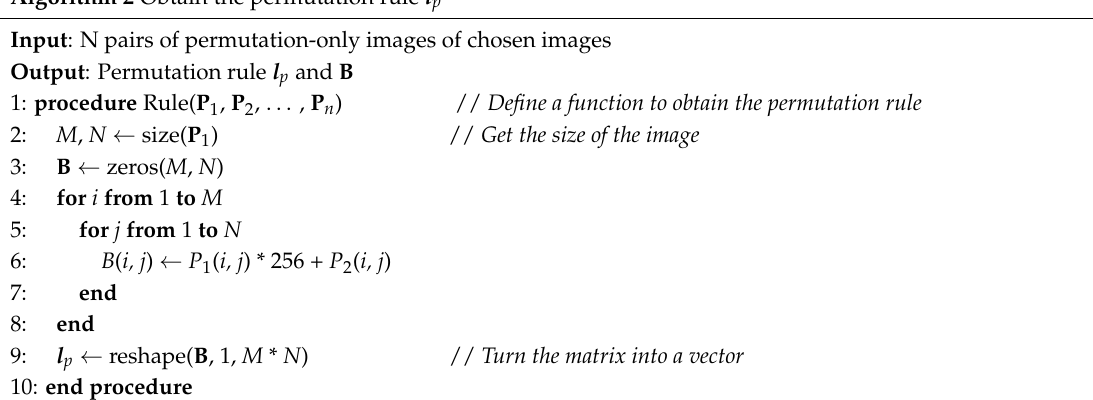
Algorithm 2 Obtain the permutation rule l